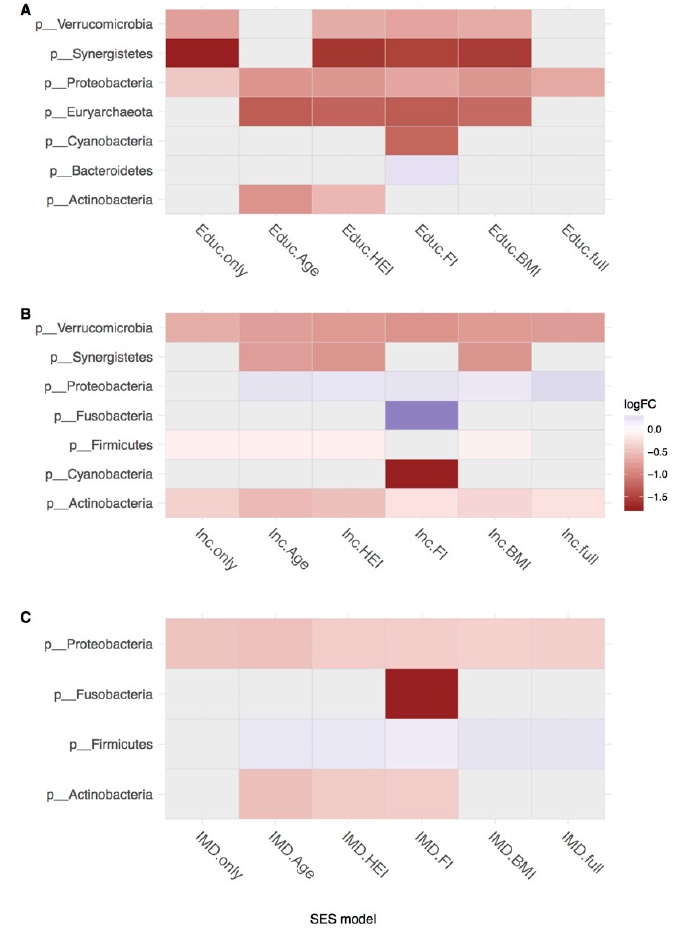
Figure 3. Differential abundance of phyla in hierarchical models. DeSeq2 was used to calculate the differential abundance of OTUs collapsed to phylum level in hierarchical models that were crude, adjusted for age, diet (HEI), health deficit (FI), and Body Mass Index (BMI) separately and together in three socioeconomic status (SES) measures: ( A ) education, ( B ) income, and ( C ) IMD. Only FDR-adjusted results significant above q < 0.05 are shown.